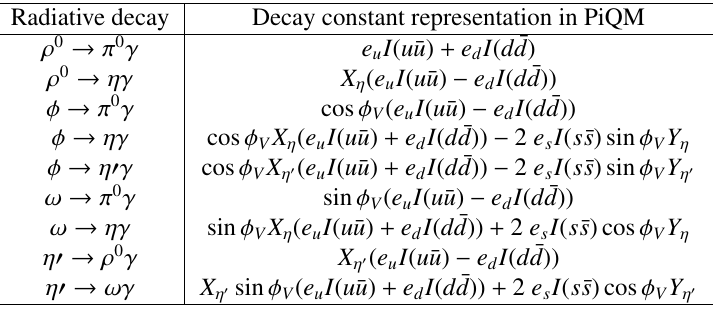
Table 1. Decay analysis in